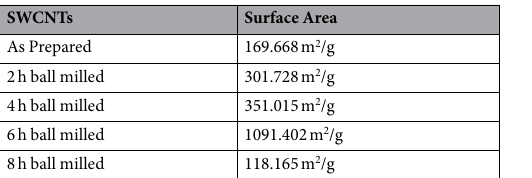
Table 1. Alterations in surface area of SWCNTs due to ball milling measured by BET